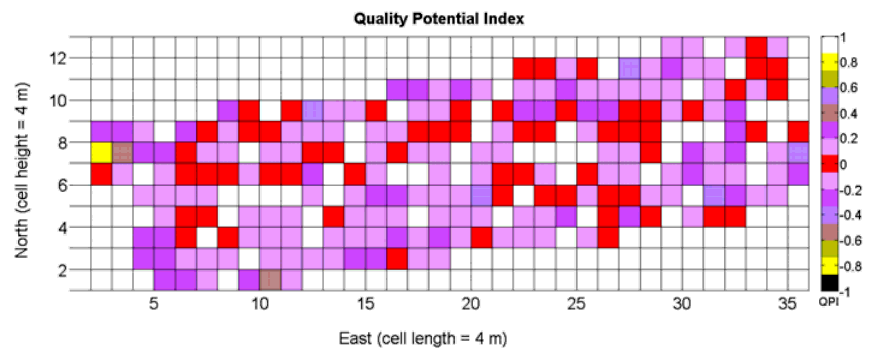
Figure 25. CB map for the Quality Potential Index QPI.